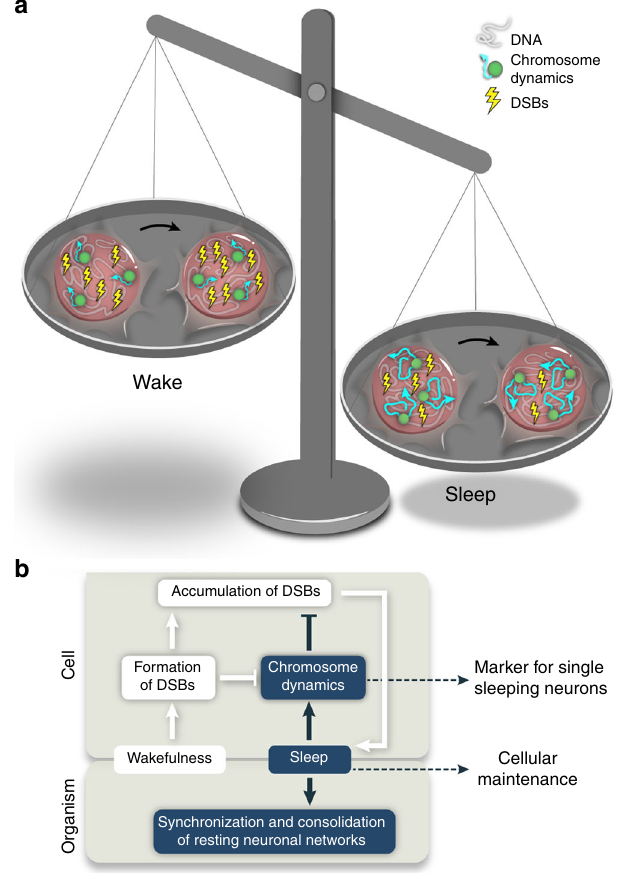
Fig. 6 A proposed function for sleep. a During wakefulness, chromosome dynamics are low and the number of DSBs is accumulated in neurons. The bene fi cial role of sleep is to increase the chromosome dynamics that are essential for the ef fi cient reduction of the number of DSBs in single neurons. b DSBs are increased in the nucleus during wakefulness and are formed by intrinsic and extrinsic factors, such as neuronal activity, irradiation, and oxidative stress, when chromosome dynamics are low. At a given threshold, accumulations of DSBs in multiple neuronal networks can trigger sleep, which increases chromosome dynamics that are necessary for the reduction of DNA damage. This mechanism suggests that chromosome dynamics can de fi ne single sleeping neurons, and that one of the functions of sleep is